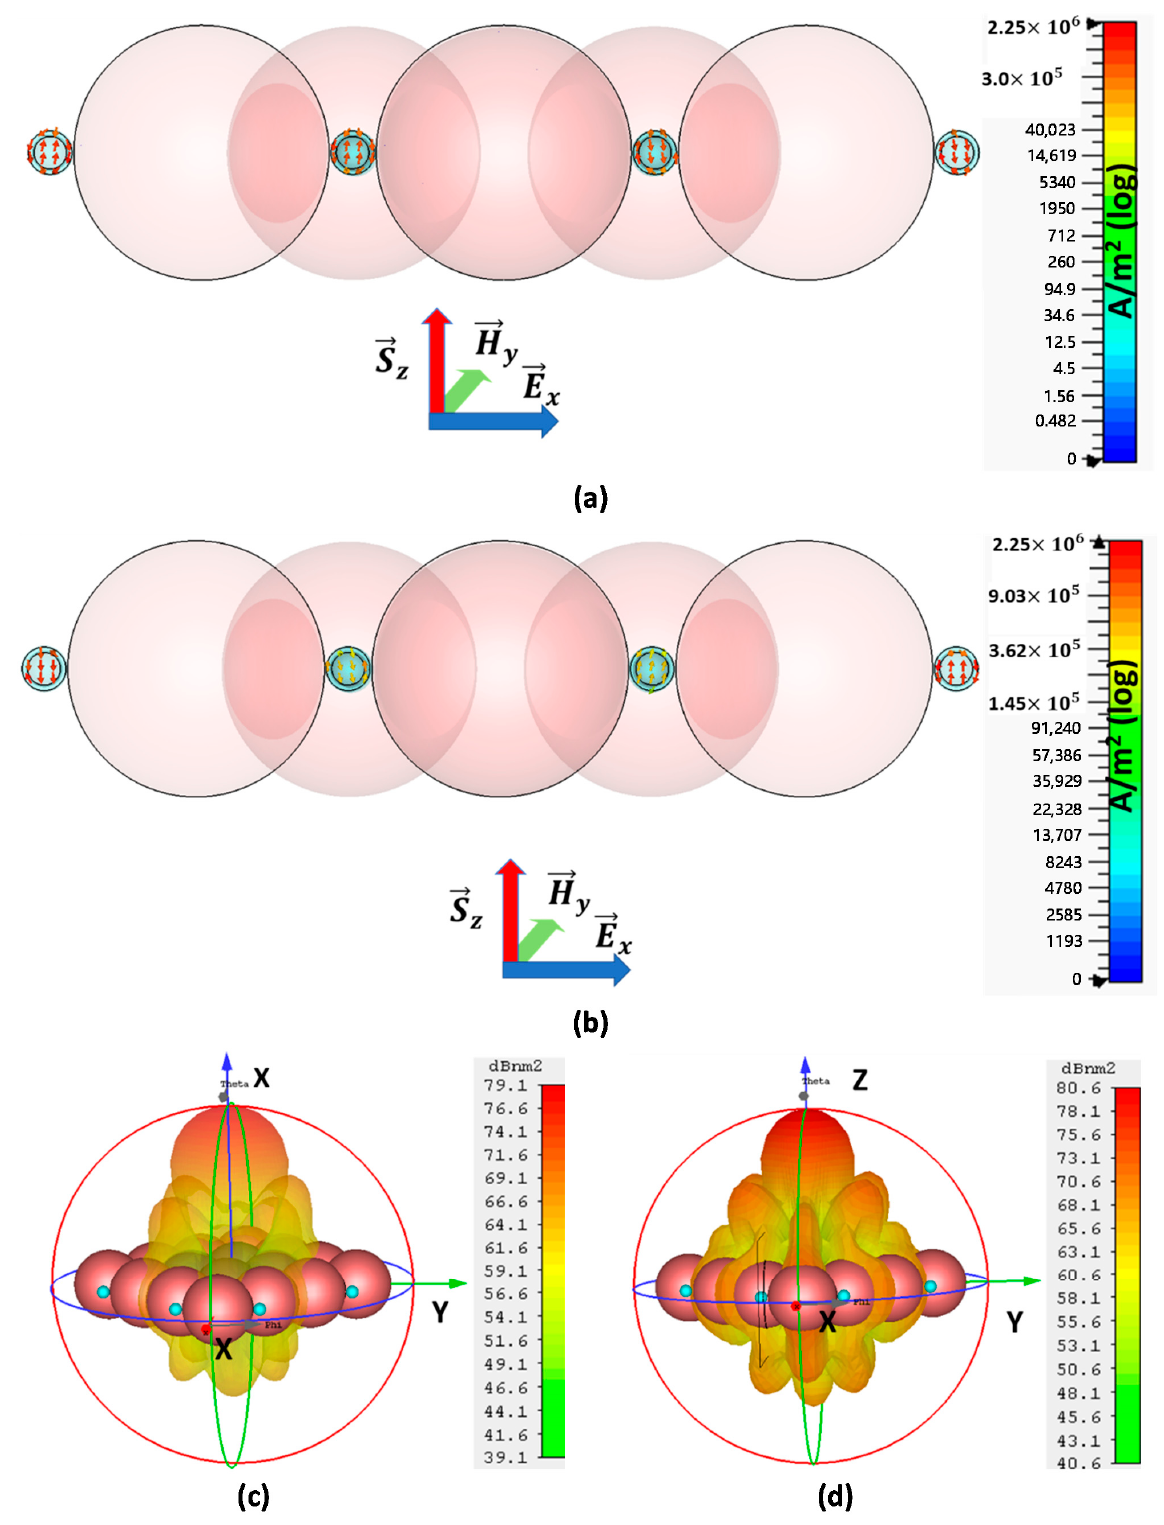
Figure 12. Current distribution and far field of the extended array of model-II at nearby resonance frequency: ( a ) current density below resonance frequency ( at f = 599.970 THz ) , ( b ) current density above resonance frequency (at f = 599.9911 THz ) , ( c ) far-field pattern at lower frequency f = 599.970 THz and ( d ) the far-field pattern at higher frequency f = 599.9911 THz ) for extended array.